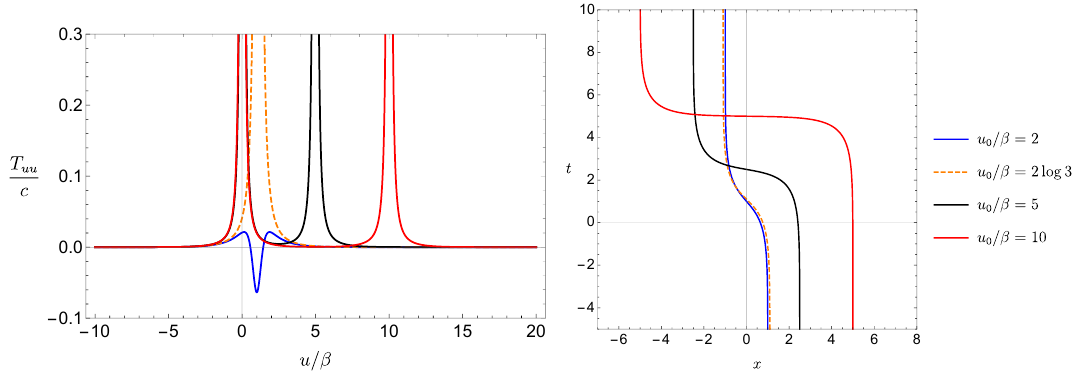
( u ) in TST 2 log 3 , 0 /β > ±